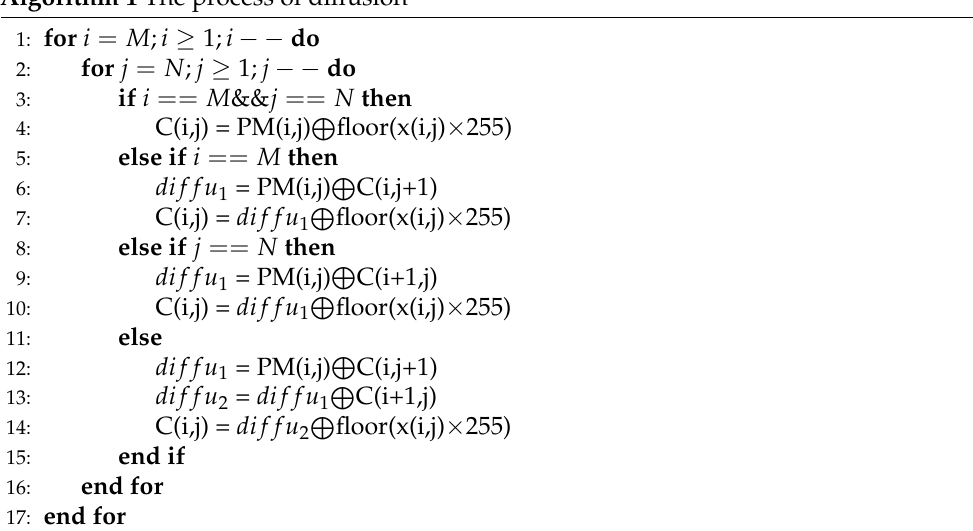
Algorithm 1 The process of diffusion